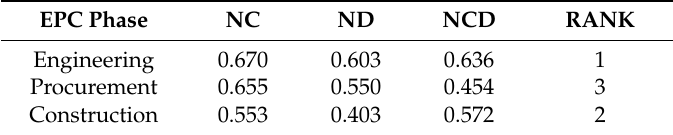
Table 4. Ranking EPC phases and their impact on project